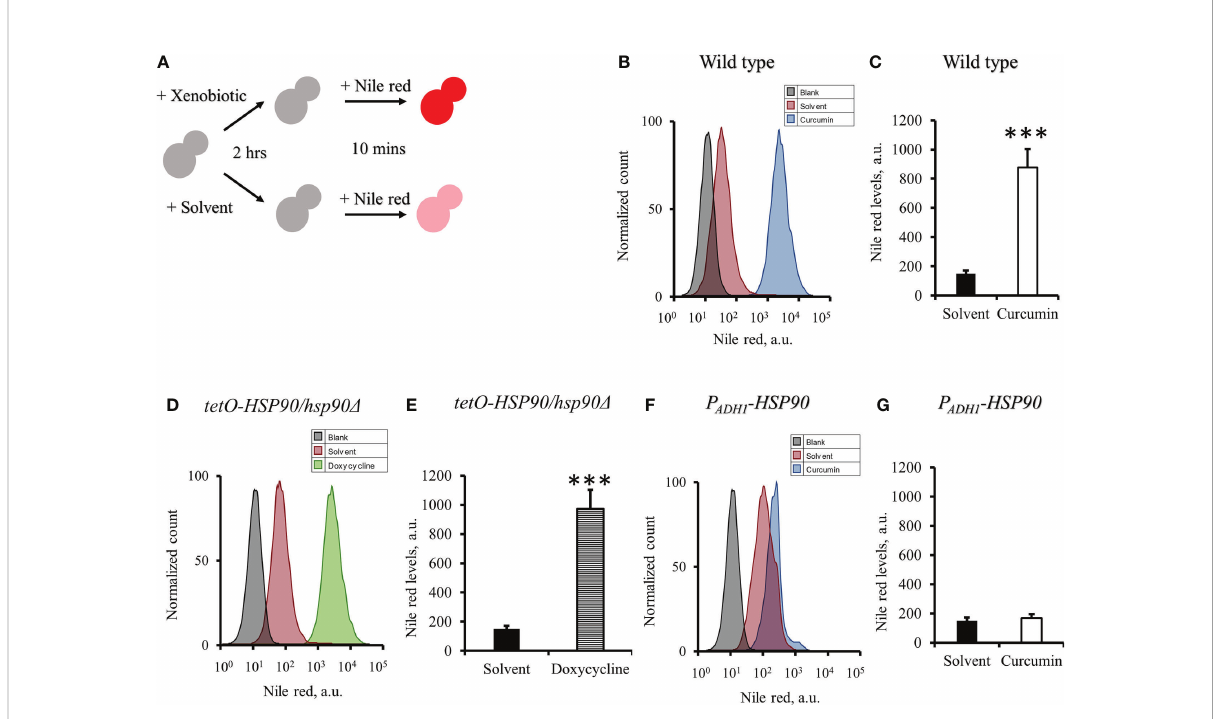
FIGURE 7 Effect of curcumin on the ef fl ux pump activity of C. albicans . (A) Diagram showing the Nile red accumulation assay to determine the disruption of ef fl ux pump activity by curcumin. The amounts of Nile red accumulated in C. albicans after treatment with curcumin for 2 h were determined for SC5314 (B, C) and the P ADH1 -HSP90 mutant (F, G) , and that in the tetO-HSP90/hsp90 D mutant was determined after treatment with Dox for 2 h (D, E) Flow cytometry histograms for mean Nile red fl uorescence are shown in C, E, G . Error bars represent standard deviation from the mean of duplicate measurements. *** indicates a statistically signi fi cant difference (p<0.001) compared to the respective control